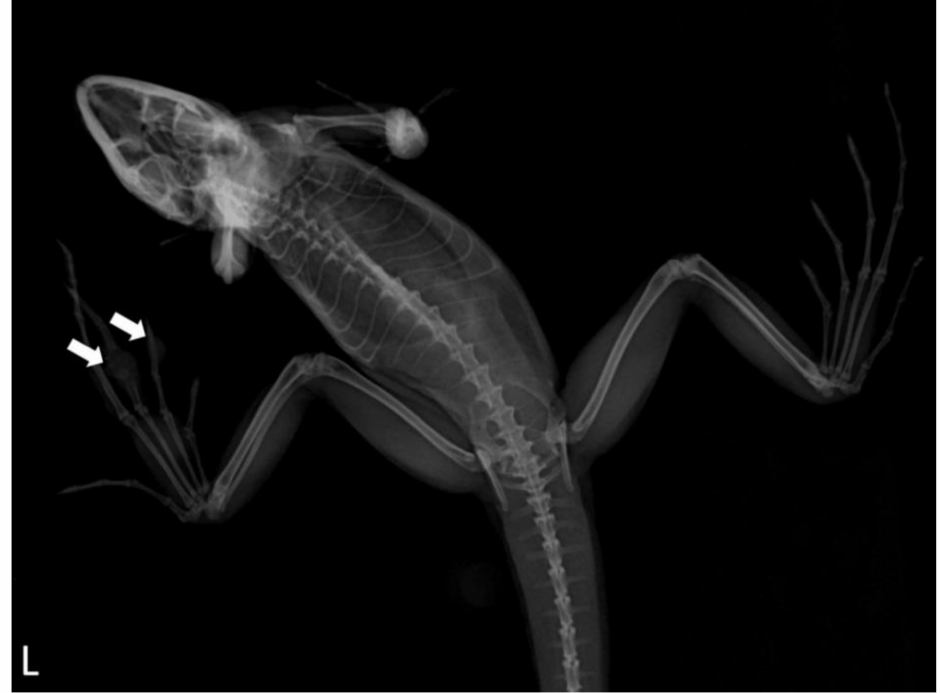
Figure 2. Dorsoventral (DV) vertical radiographic views of the left hind foot. Note the soft tissue mass on the digit with bone lysis